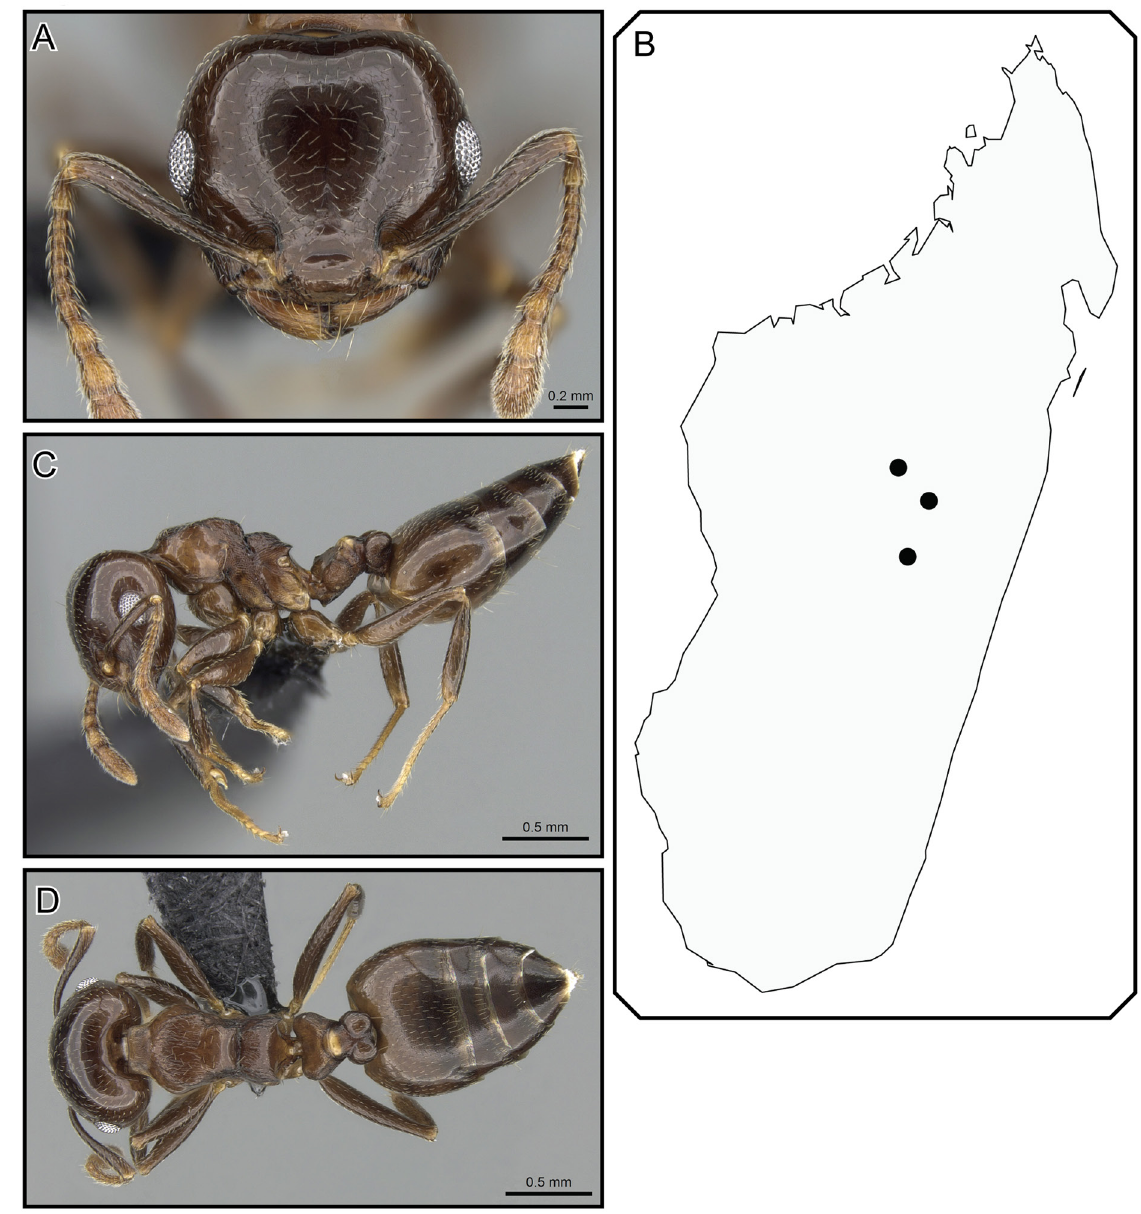
Fig. 17. Crematogaster malahelo sp. nov., worker and distribution. A, C-D. Worker (CASENT0317768). A. Full-face. C. Profile. D. Dorsal. B. Species